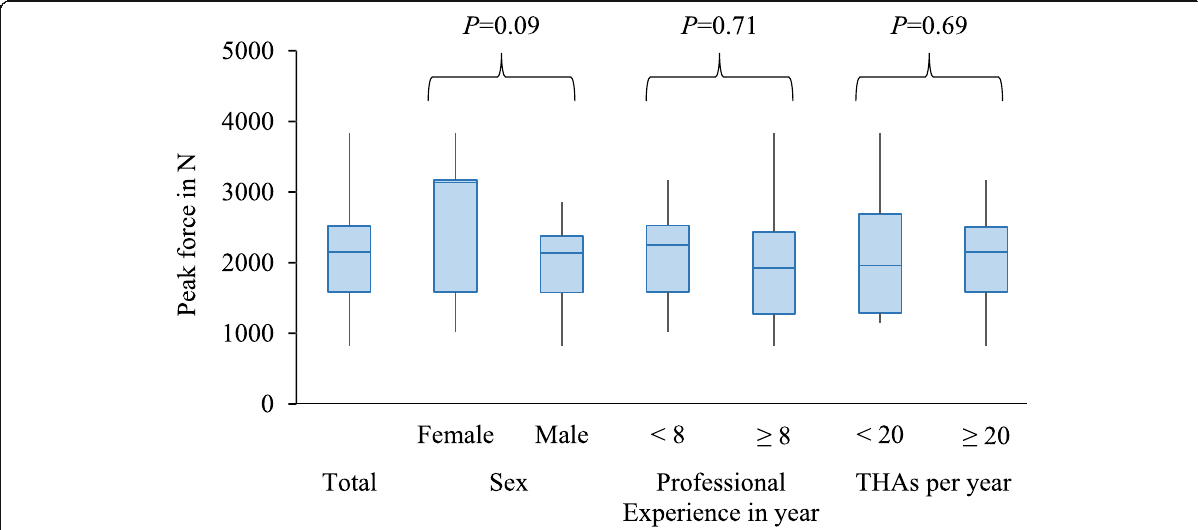
Fig. 8 Box plot with determined peak forces in several groups of